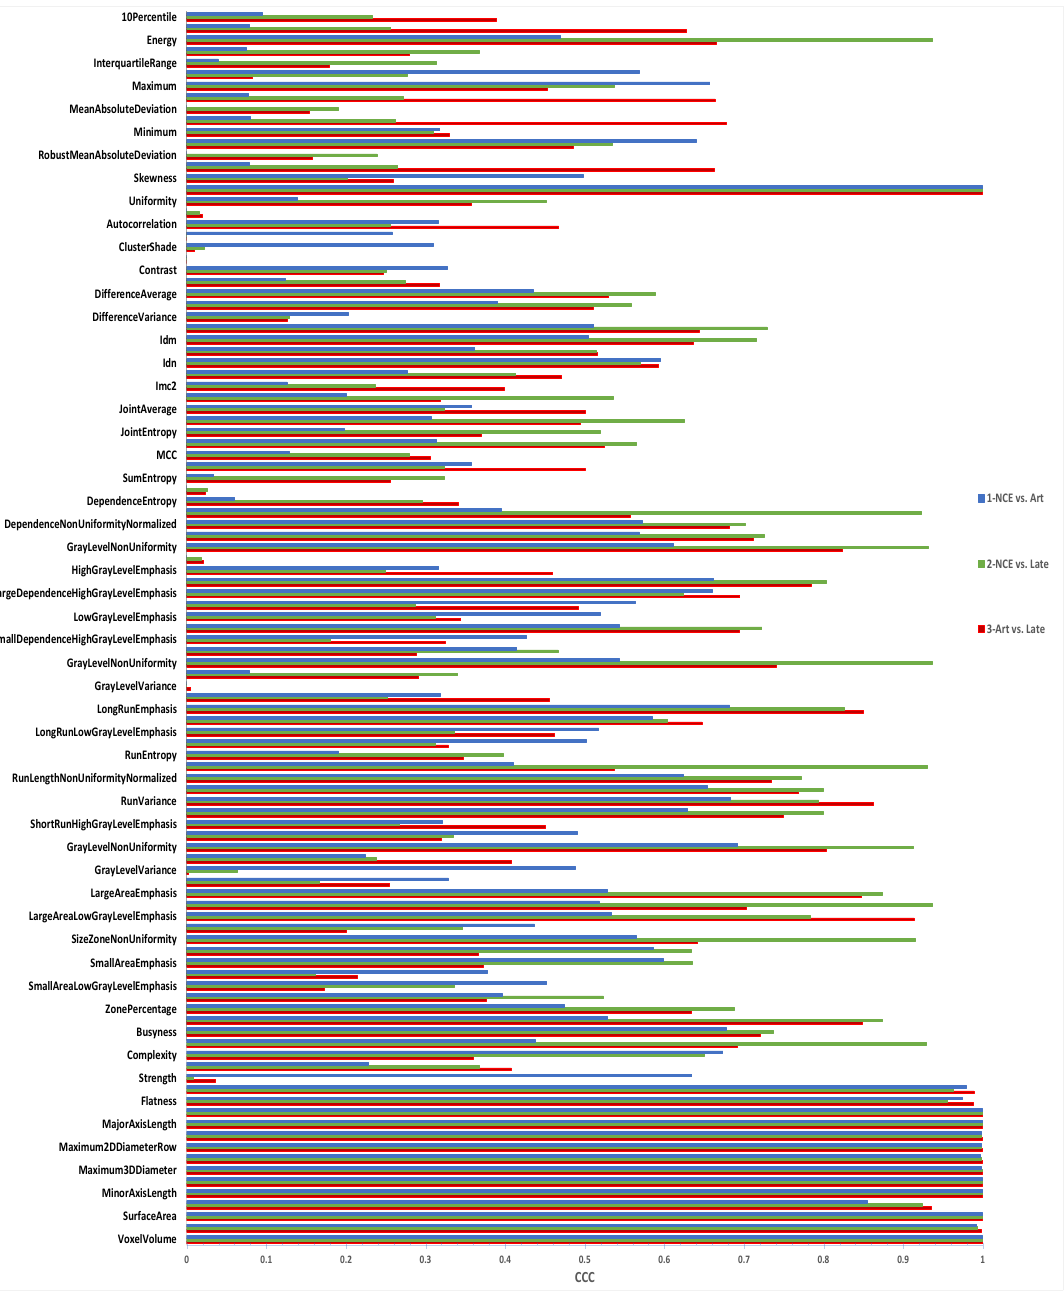
Figure 2 . CCC values for RFs across the different imaging phases after ComBat harmonization. Figure 2. CCC values for RFs across the different imaging phases after ComBat